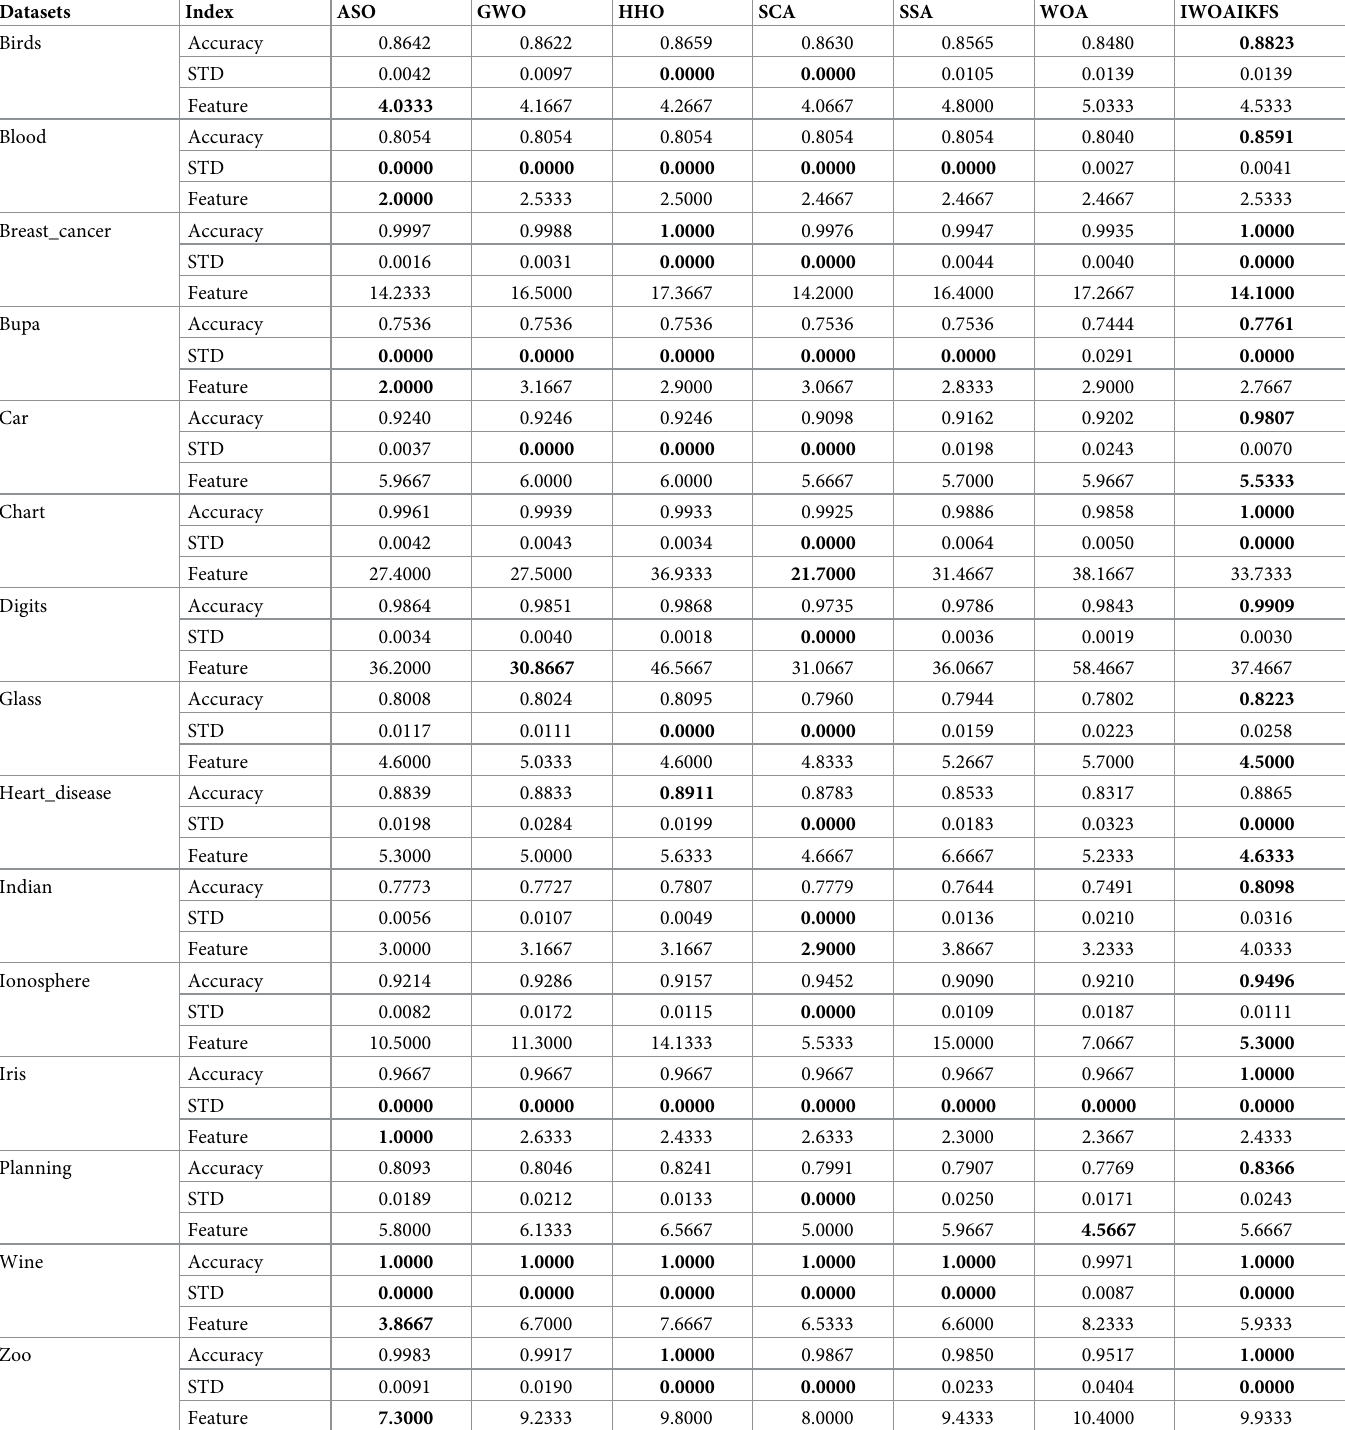
Table 10. Comparison between IWOAIKFS with other competitor optimizers based on accuracy ( k = 5 and best are in bold).